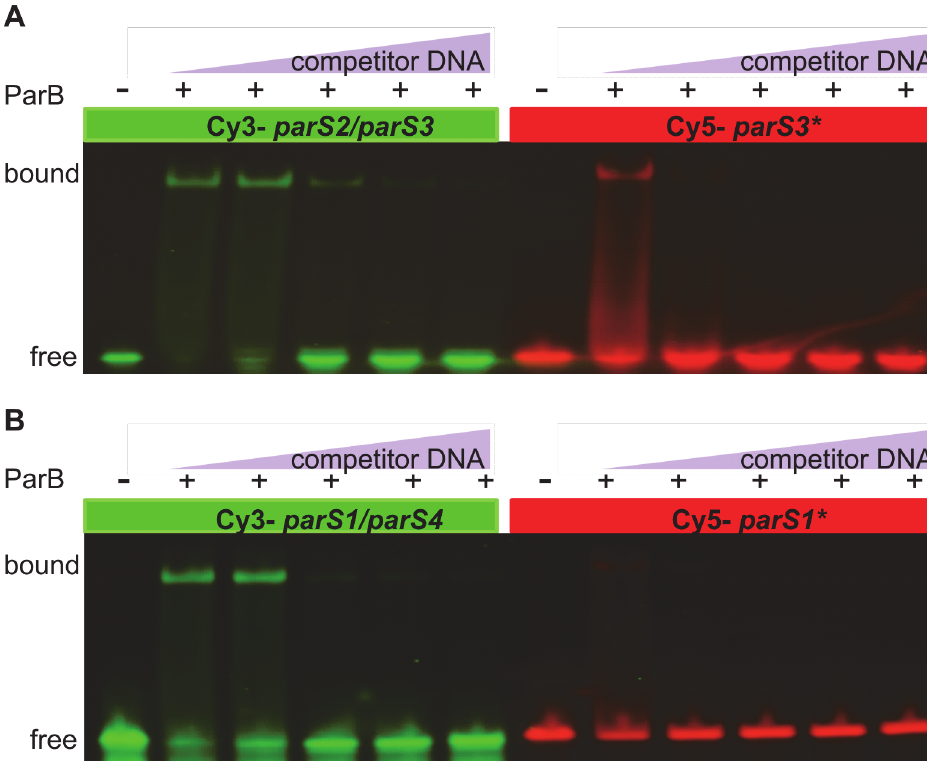
Fig 3. ParB binds modified parS sites with lower affinity than the wild-type counterparts. Differently labelled wt and their mutated versions were used in EMSA (A) parS2/3 vs. parS3 * and (B) parS 1 vs. parS1 * . Six pmoles of labelled nucleotides were incubated with 240 pmoles of His 6 -ParB and increasing amounts (18, 60, 90, 120, 180 pmoles) of unlabelled ds parS2 oligonucleotide used as competitor DNA. After incubation at 37°C for 15 min, the complexes were separated on a native 5% polyacrylamide gel in TBE buffer, the DNA was visualized with FluorChemQ MultiImageIII ChemiImager and the images were captured using AlphaView software (Alpha